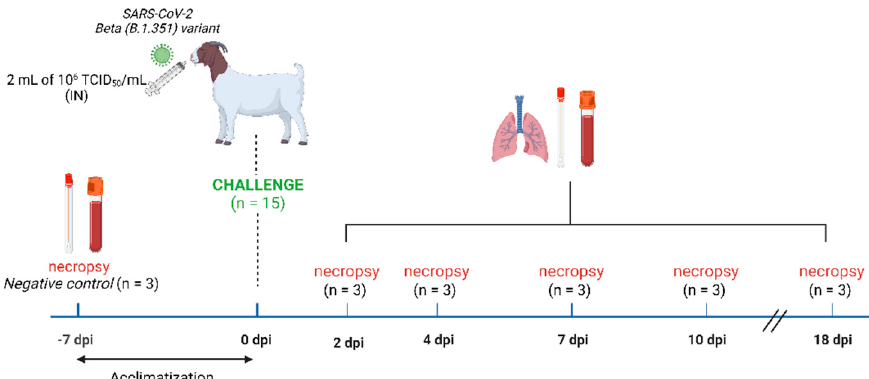
Figure 1. Schematic representation of the study design. Three out of eighteen goats were necropsied on the day of arrival and served as non-inoculated controls. Nasal and rectal swabs, blood, and tissue samples were collected. After acclimatisation, the remaining fifteen goats were intranasally inoculated with the SARS-CoV-2 B.1.351/Beta variant (2 mL of 1 × 10 6 TCID 50 /animal). At 2, 4, 7,10, and 18 days post-infection, three goats were necropsied each day and nasal and rectal swabs, blood, and tissues were collected. Clinical signs and rectal temperature were recorded daily.